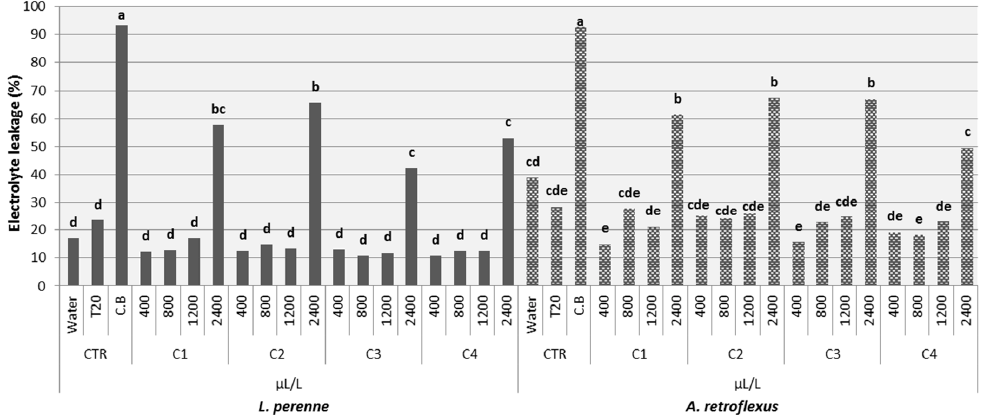
Figure 3. Effect of the different EOs at different doses on the relative electrolyte leakage of A. retroflexus and L. perenne seedlings, measured 48 h after treatment. CTR: Controls, T20: Tween 20